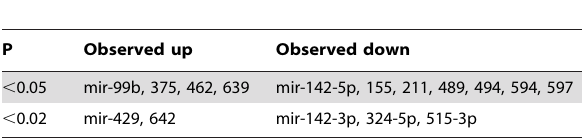
Table 3. Quantile rank analysis of miRNA expression